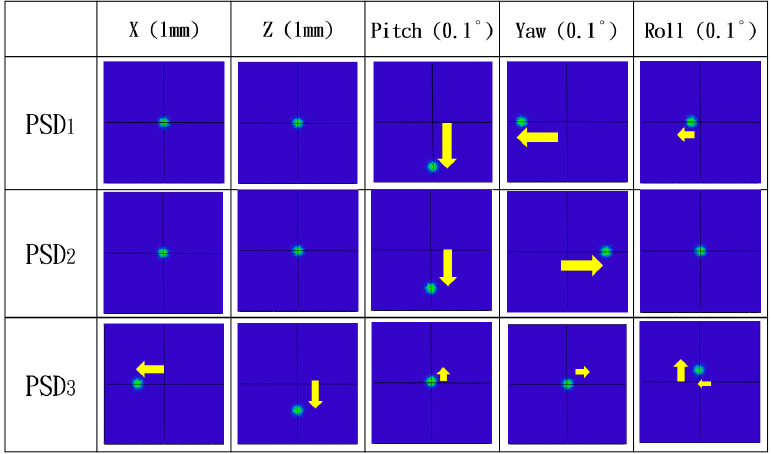
Figure 7. Simulation results showing variation of light spot positions on PSDs with geometric errors.